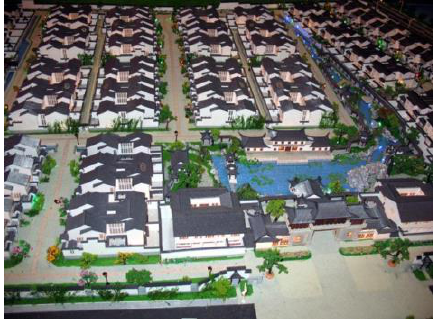
Figure 20. Villas, alley, pavilion, and corridor at Suzhou Fuyuan. Source: Suzhou Guardian Real Estate Development Co. 2007.